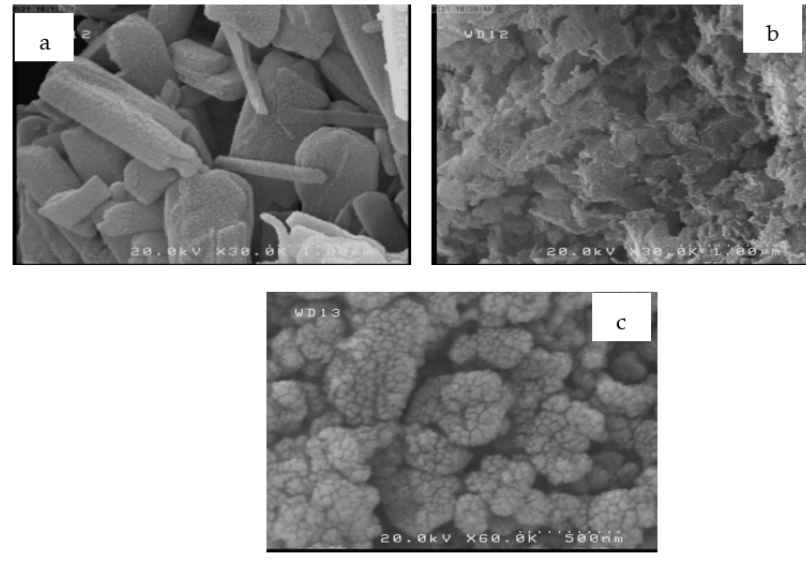
Figure 1. SEM images of: ( a ) RS, ( b ) RSAC, and ( c ) nZVFe–RSAC. Table 4. The kinetic parameters of the adsorption of Pb(II) on the RS, RSAC, and nZVFe–RSAC.